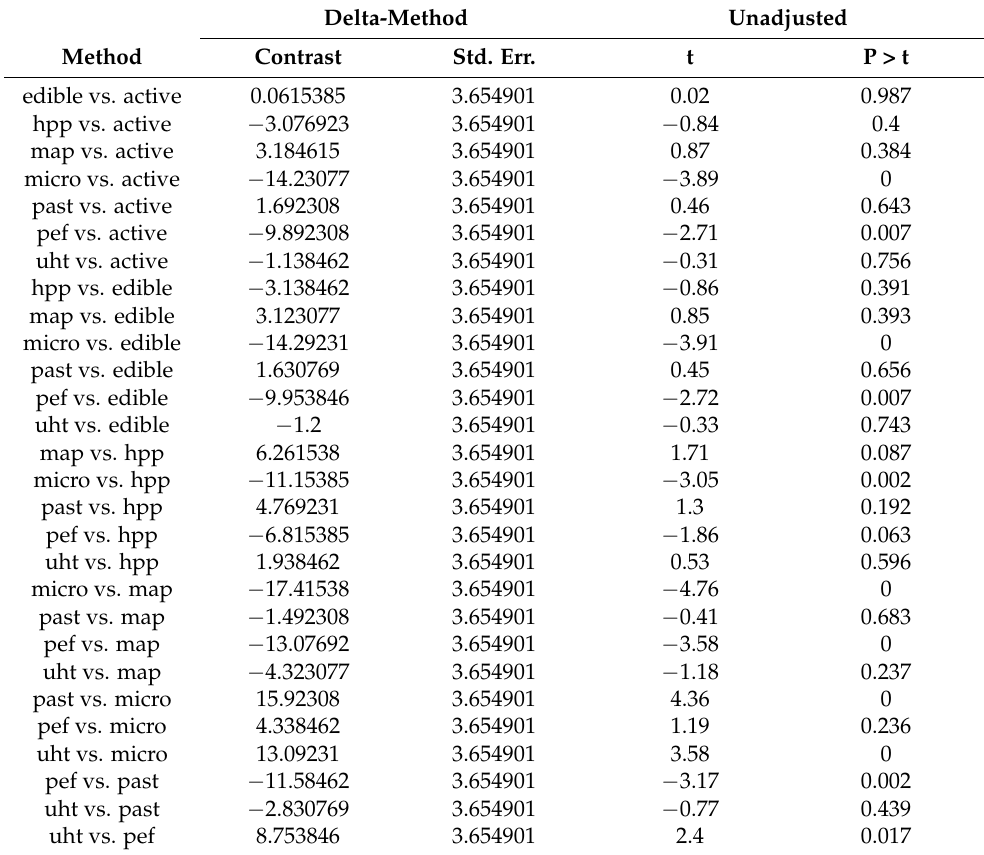
Table A2. Pairwise-comparisons of predictive margins for monochromatic color scheme.